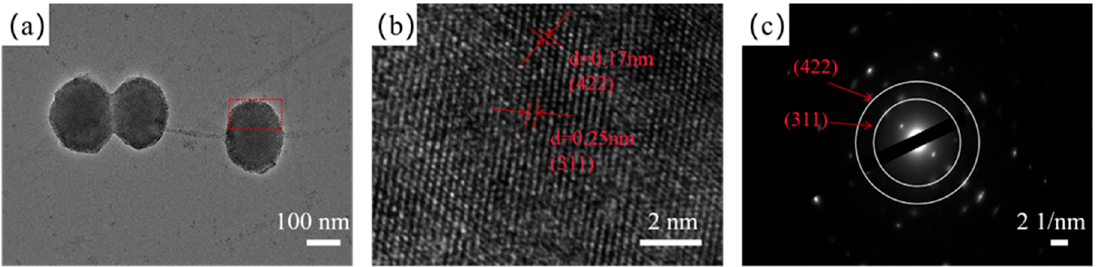
Figure 3. SEM images of CoFe 2 O 4 /SWCNTs composites under Co salt gradient: ( a ) Co-1, ( b ) Co-2, ( c ) Co-3, ( d ) Co-4.